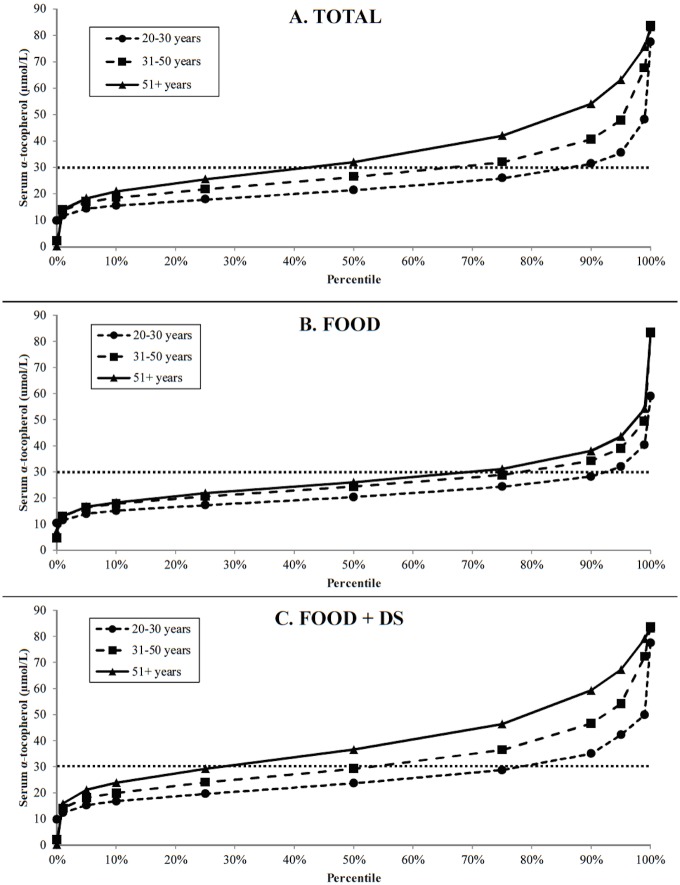
Proportion (%) of adults ≥20y at or below the serum α-tocopherol concentration shown on the Y-axis, excluding pregnant or lactating women, for the total population and by supplement use.The dotted horizontal line represents a criterion of adequacy set at 30 μmol/L.